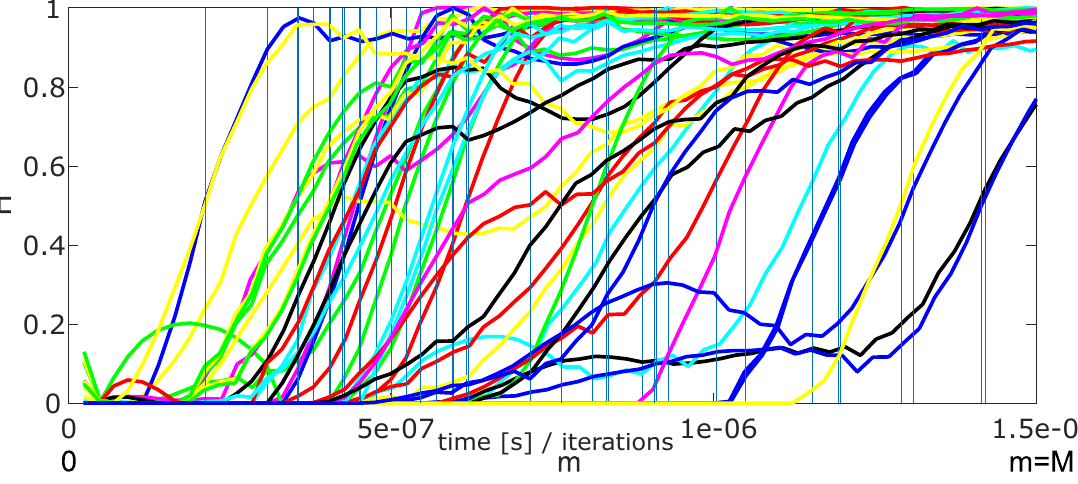
Figure 8. Shannon entropy ( H ) as a function of m for 50